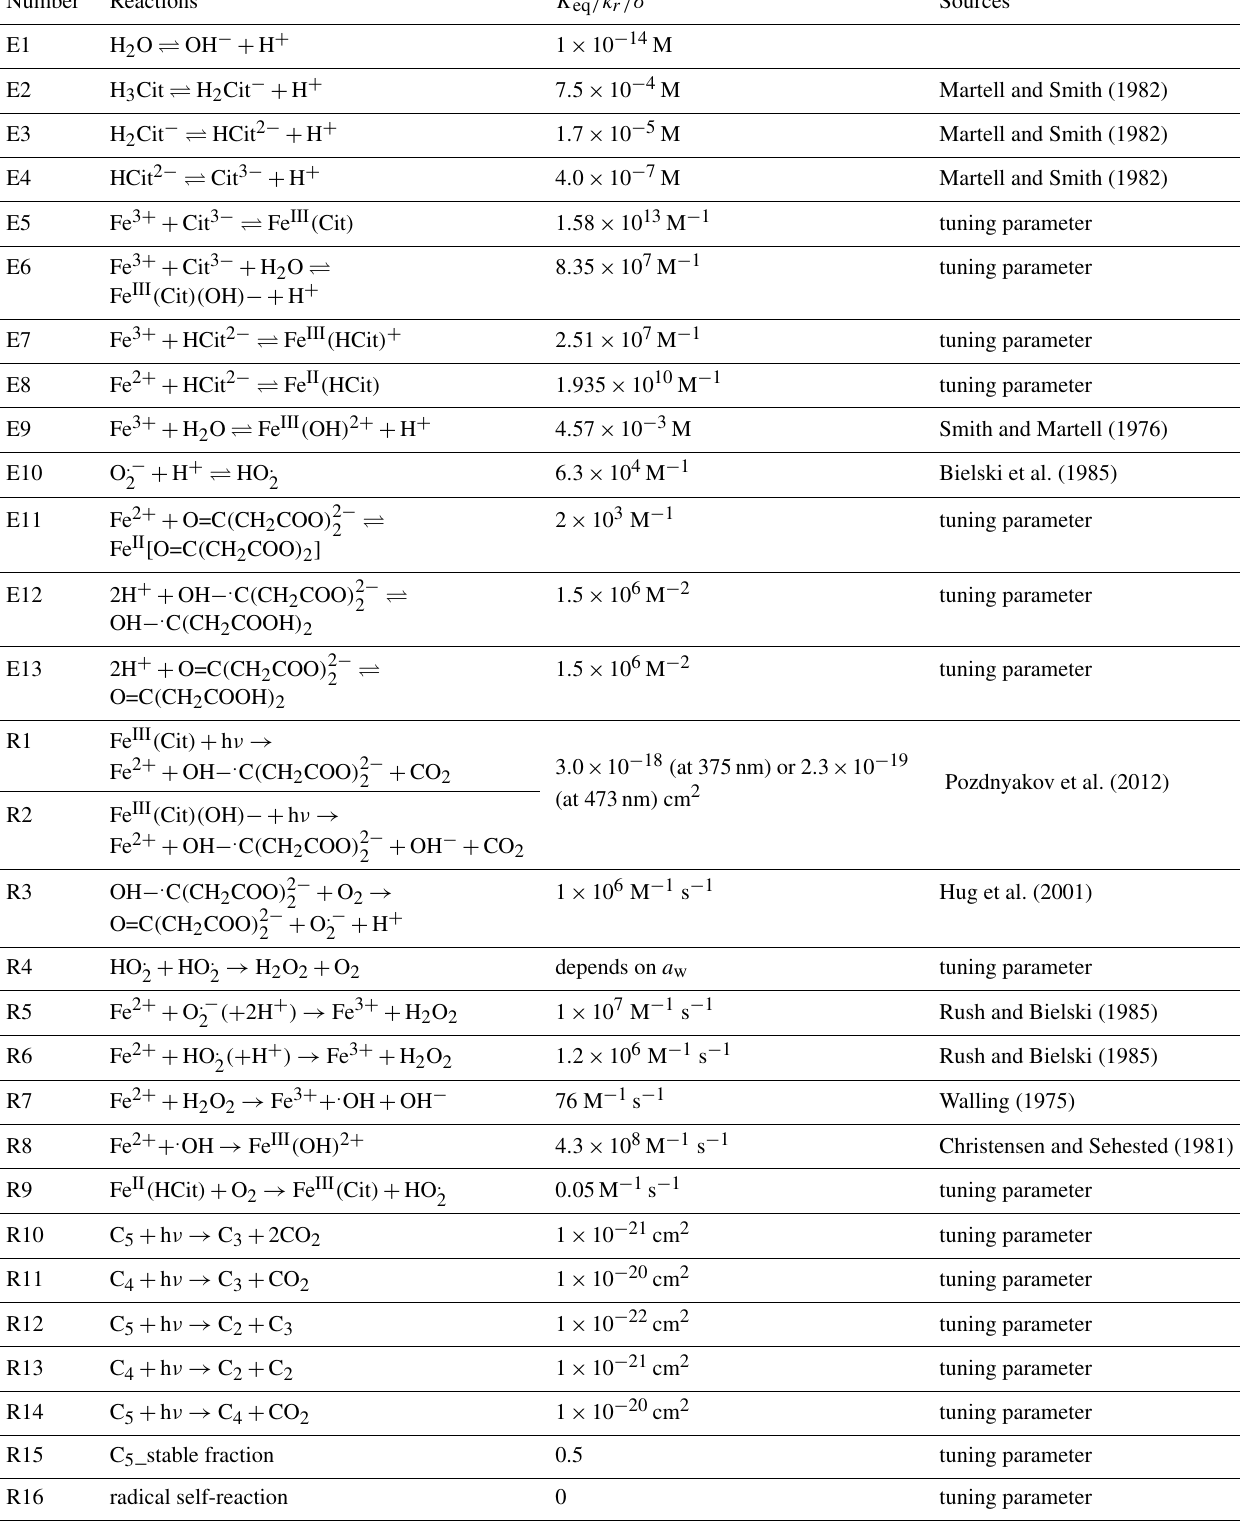
Table 2. Compilation of equilibria, chemical reactions, and corresponding rate constants in Fe III ( Cit ) photochemistry system.